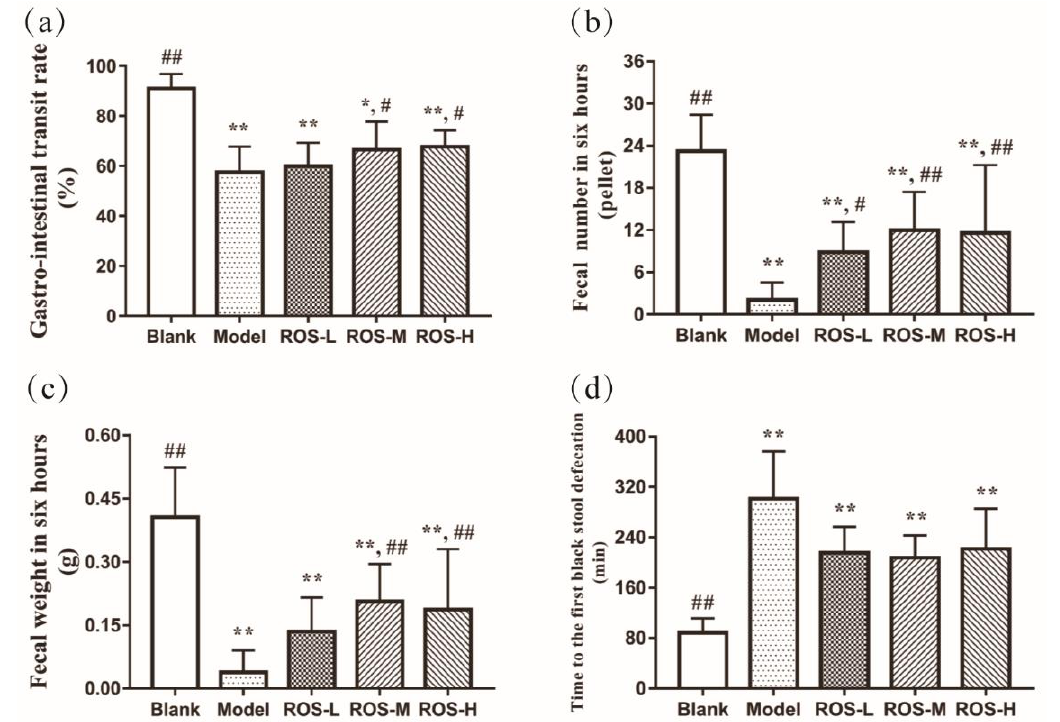
Figure 1. Gastro-intestinal transit rate ( a ) and defecation status: the weight ( c ) and number ( b ) of defecation events in six hours and the time to the first black stool defecation ( d ) of mice. Blank: distilled water treated; Model: Loperamide treated; ROS-L: low-dose ROS treated; ROS-M: medium- dose ROS treated; ROS-H: high-dose ROS treated. * p < 0.01 than in the blank group; ** p < 0.01 than in the blank group; # p < 0.05 and ## p < 0.01 than in the model group.